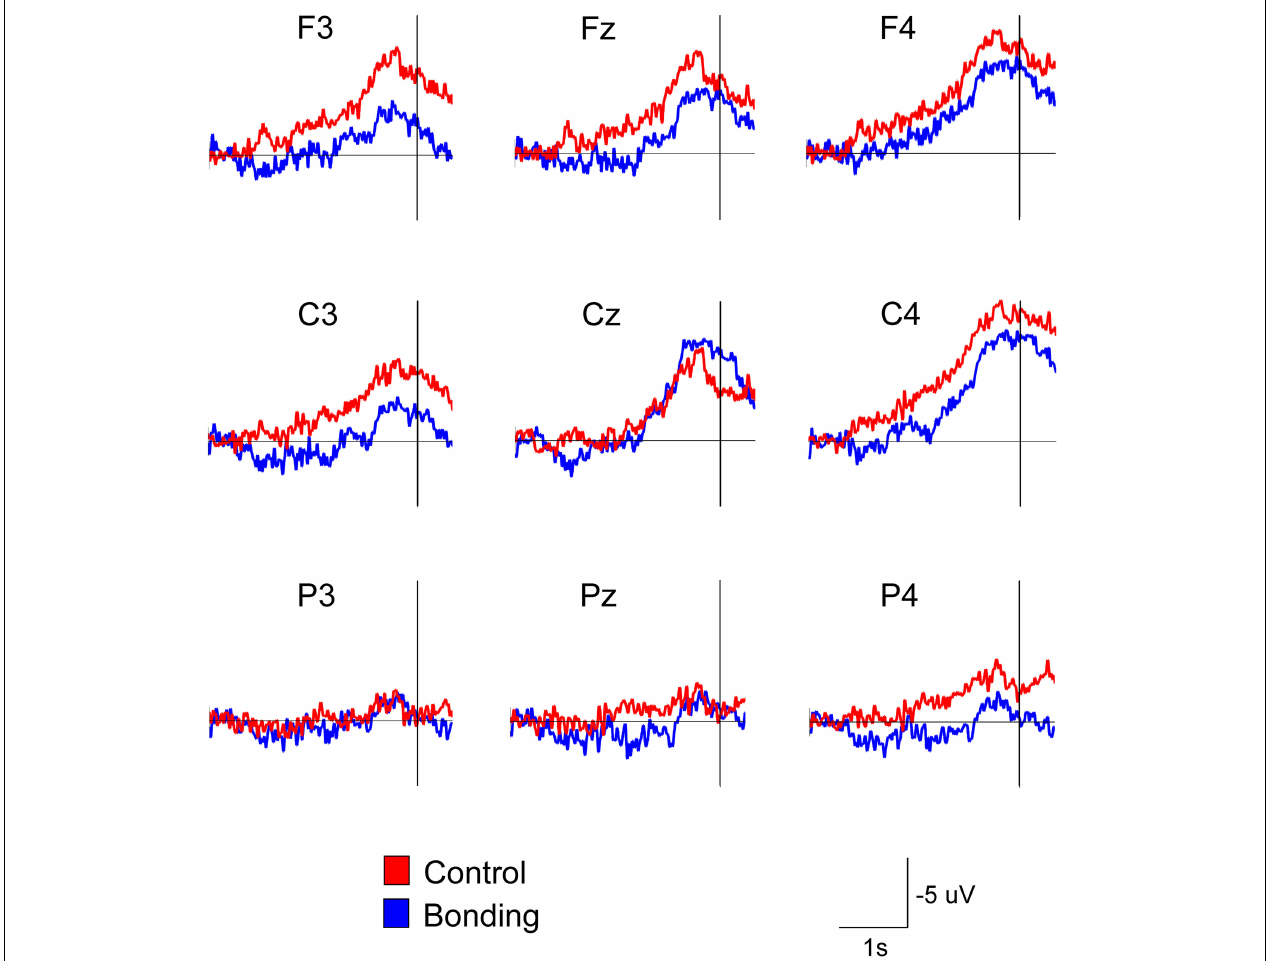
FIGURE 2 | Attenuation of the readiness potential by previous exposure to bonding pictures. Grand averages for the nine electrodes in the “bonding” (blue) and “control” (red) conditions are depicted. Vertical lines represent movement onset.